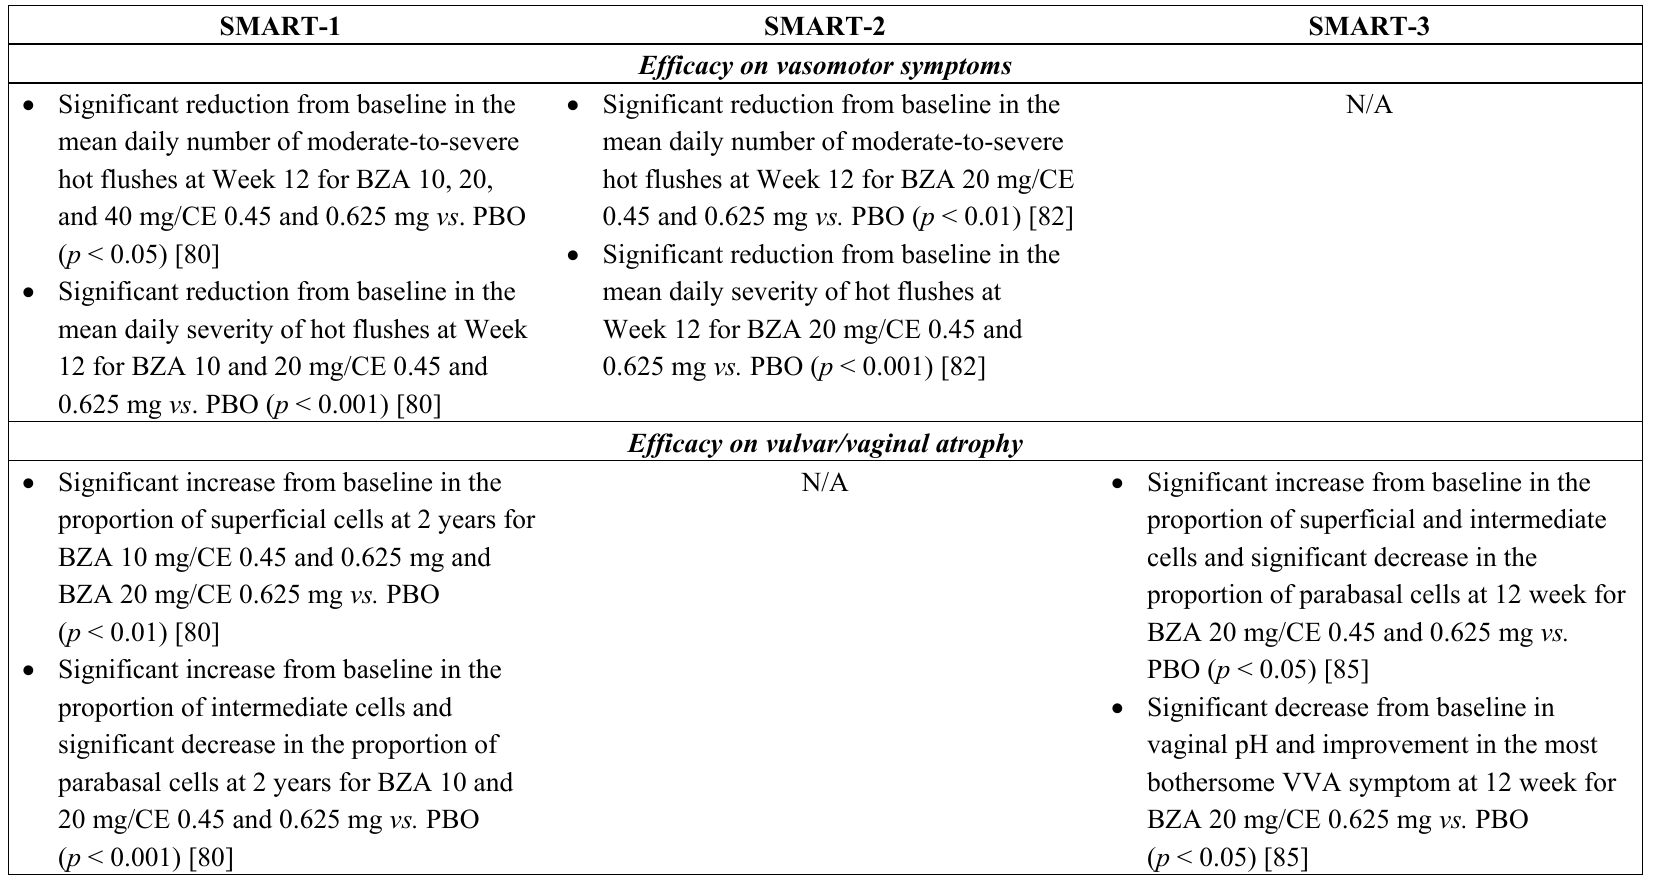
Table 3. Summary of key efficacy findings in the SMART